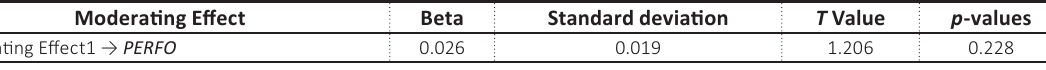
Table 6. Moderating effect of the behavior of jobseekers